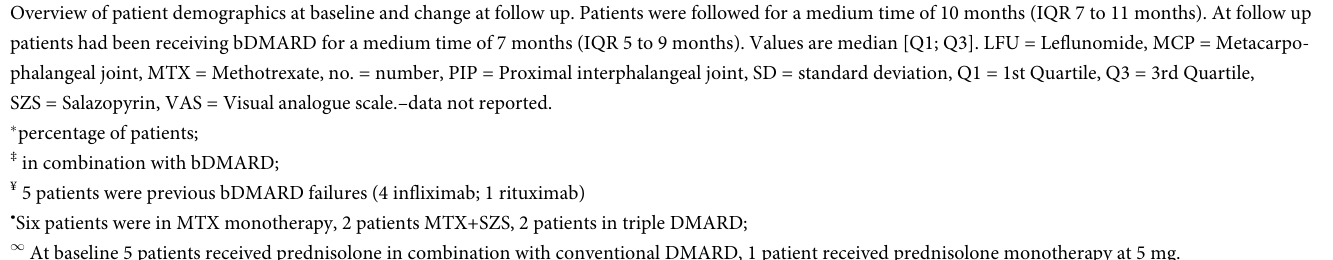
(CL = 1.06; 11.25). IL-6 production of bDMARD-cultured samples was significantly lower 95 than matched isotype controls in samples from good responders (P = 0.01), with a mean decrease of 45% (CL = 66%; 14%). The difference in IL-6 production was borderline signifi- 95 cant with regards to spontaneous production and bDMARD (P = 0.06). No significant differ- ences were seen with regards to in vitro effects among moderate responders or no responders, or with any groups and changes in MCP-1. For further details please consult Fig 2 and S2 Table. For model optimization purposes, one data point out of 236 was excluded from the analysis (Cooks distance = 0.6). Correlation coefficients for spontaneous and bDMARD-treated explants with regards to IL-6 and changes in DAS-28 were significant (P = 0.03 for both), with ρ = 0.56 and ρ = 0.57. Scatterplots of changes in IL-6 from bDMARD-treated samples and changes in DAS-28, CF and BME are given in Fig 3. Changes in MCP-1 production were not correlated to max changes in DAS-28 (ρ = 0.37, P = 0.15).